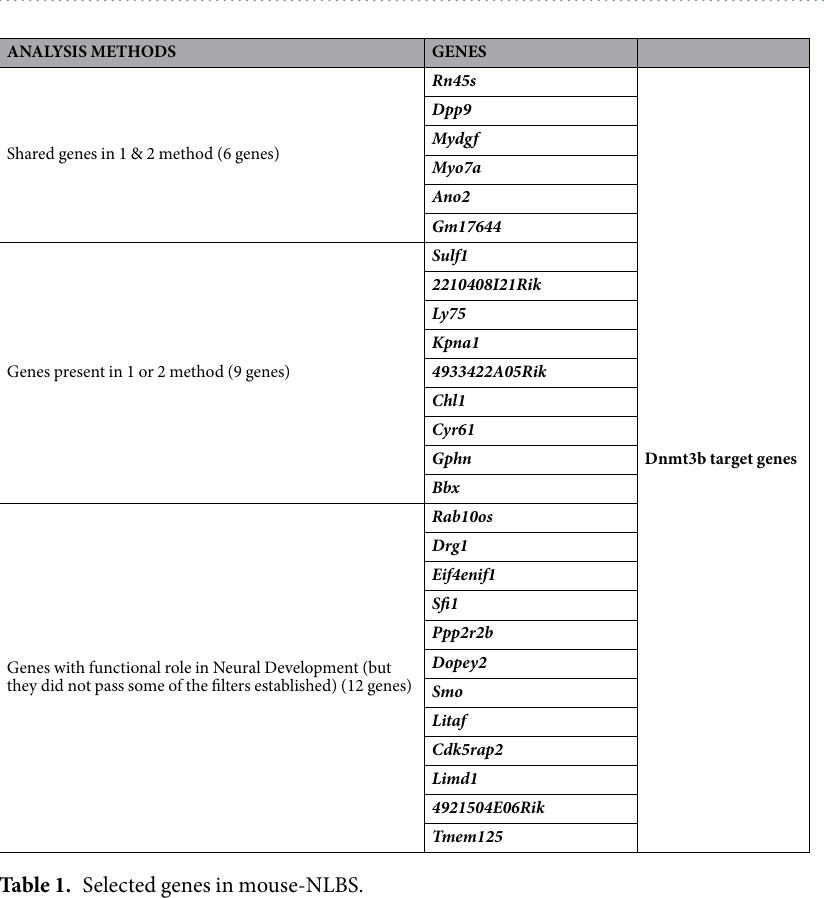
Figure 2. Peak distribution obtained in DNMT3b ChIP-seq assay. Diagram showing the peaks distribution, in which it is revealed that DNMT3b binding sites are preferentially intergenic and intronic regions.